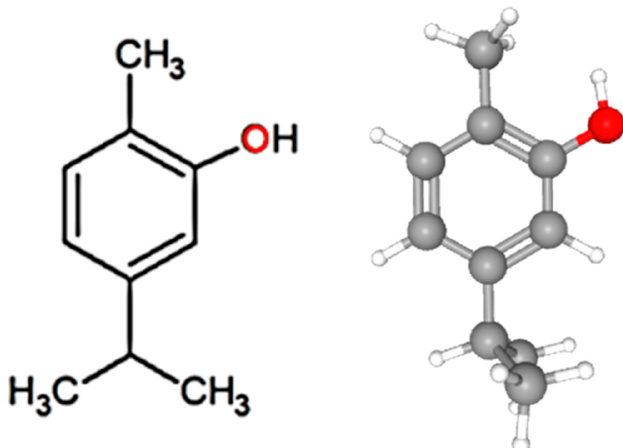
Figure 1. The chemical structure of carvacrol.